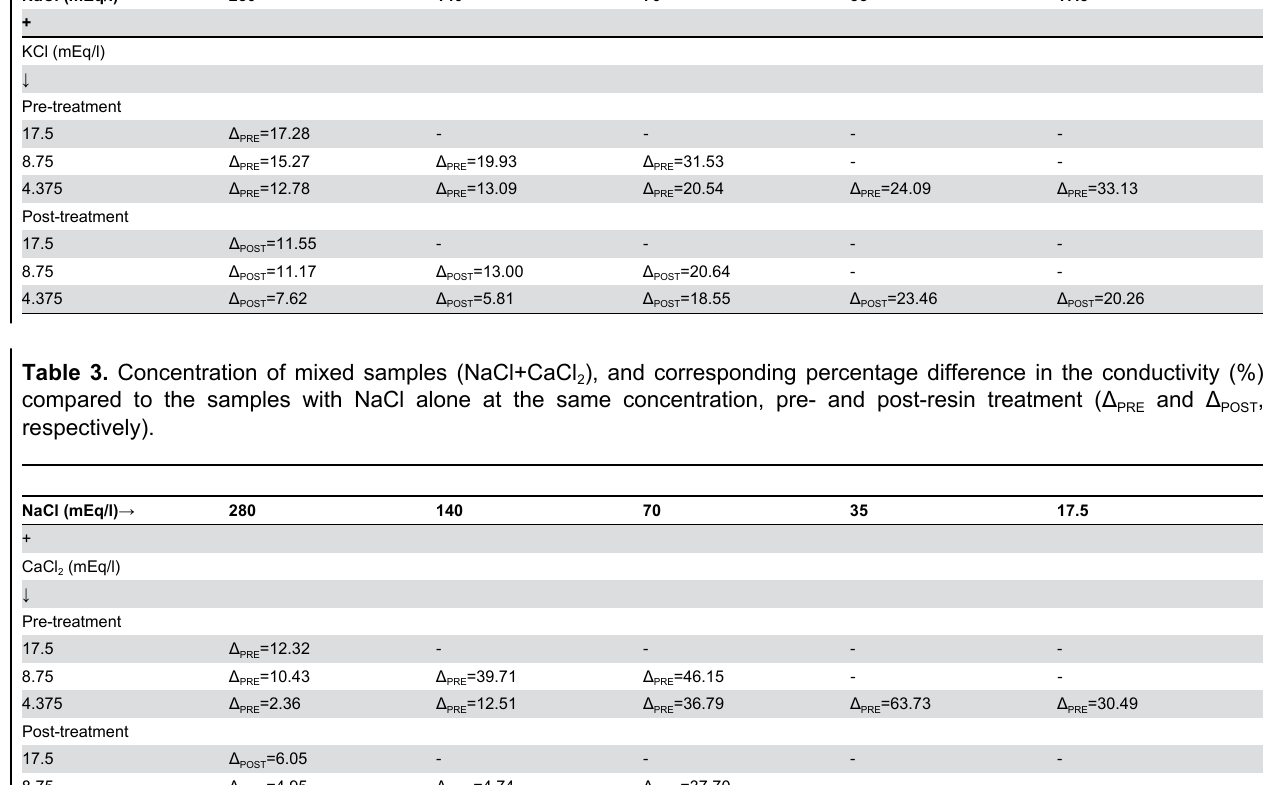
Table 4. Concentration of mixed samples (NaCl+MgCl compared to the samples with NaCl alone at the same concentration, pre- and post-resin treatment (Δ